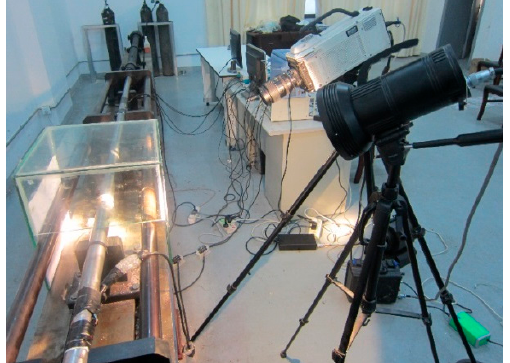
( f ) Figure 10. Impact compression failure forms of sandstone with different corrosion times. Non-cor- roded ( a ), corroded 1 d ( b ), corroded 3 d ( c ), corroded 7 d ( d ), corroded 14 d ( e ), and corroded 28 d ( f ). In terms of the specific consideration of the impact of corrosion, we believe that the reason is that with the extension of corrosion time, quartz, the main component of sand- stone, constantly reacts with OH − ions in the strong alkaline solution [19]: Si O (cid:2870) (quartz) + 2OH (cid:2879) → H (cid:2870) SiO (cid:2872)(cid:2870)(cid:2879)